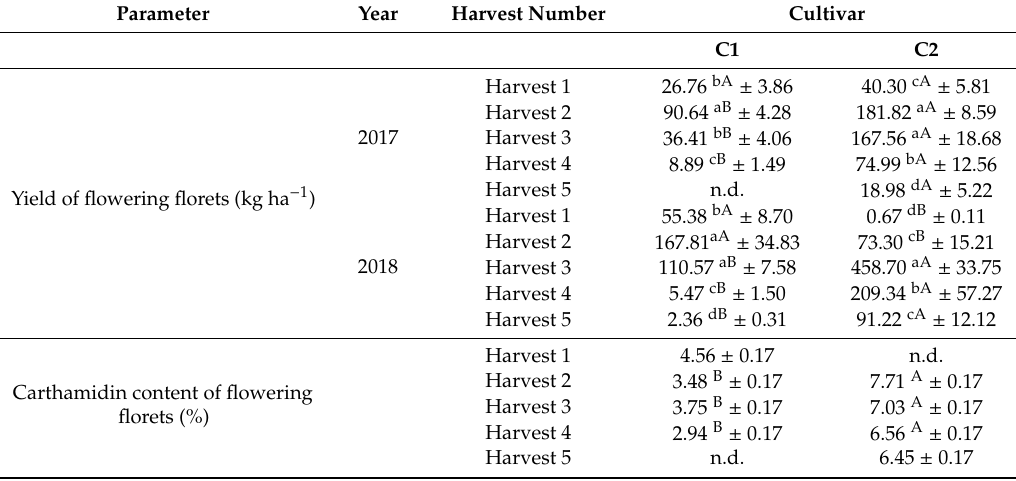
Table A1. Mean values ± standard error and significant di ff erences of the Fisher’s LSD test ( α = 0.05) for the factors year (2017 and 2018), harvest date (Harvest 1–5), and cultivar (C1 and C2). Mean values with at least one identical lowercase letter are not significantly di ff erent between harvest dates (within columns). Mean values with at least one identical capital letter are not significantly di ff erent between cultivars (within